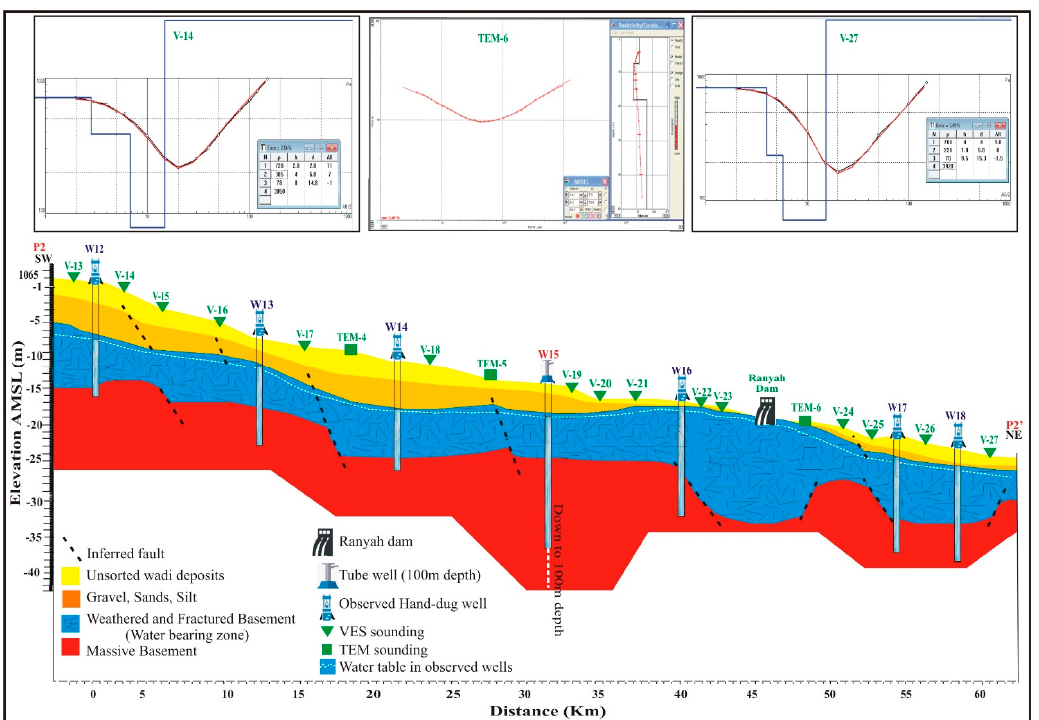
Figure 12. The geoelectric cross-section P2–P2’, with the sounding and the modeled data of VES (V-14, and V-27) and TEM-6.